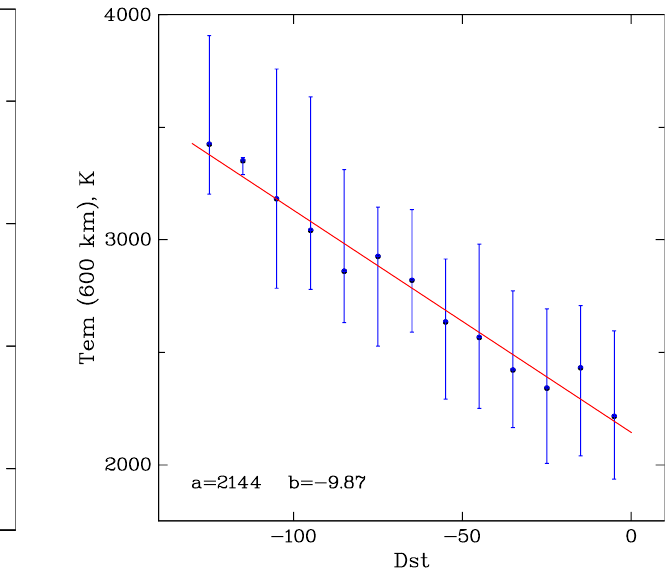
Fig. 9. Magnitude of the subauroral electron temperature enhance- ment as a function of geomagnetic activity. The Dst index is indi- cated on the abscissa, the associated peak temperature T em on the ordinate. All temperature values were adjusted to a common alti- tude of 600km using the mean temperature profile shown in Fig. 7. The blue dots and bars indicate the medians and the upper and lower quartiles of the temperature values for each 10nT-wide interval of the Dst index. Also shown is the regression line fitted to the medi- ans (red line). The associated line parameters are given in the lower left-hand corner (ordinate interception a in K, slope b in